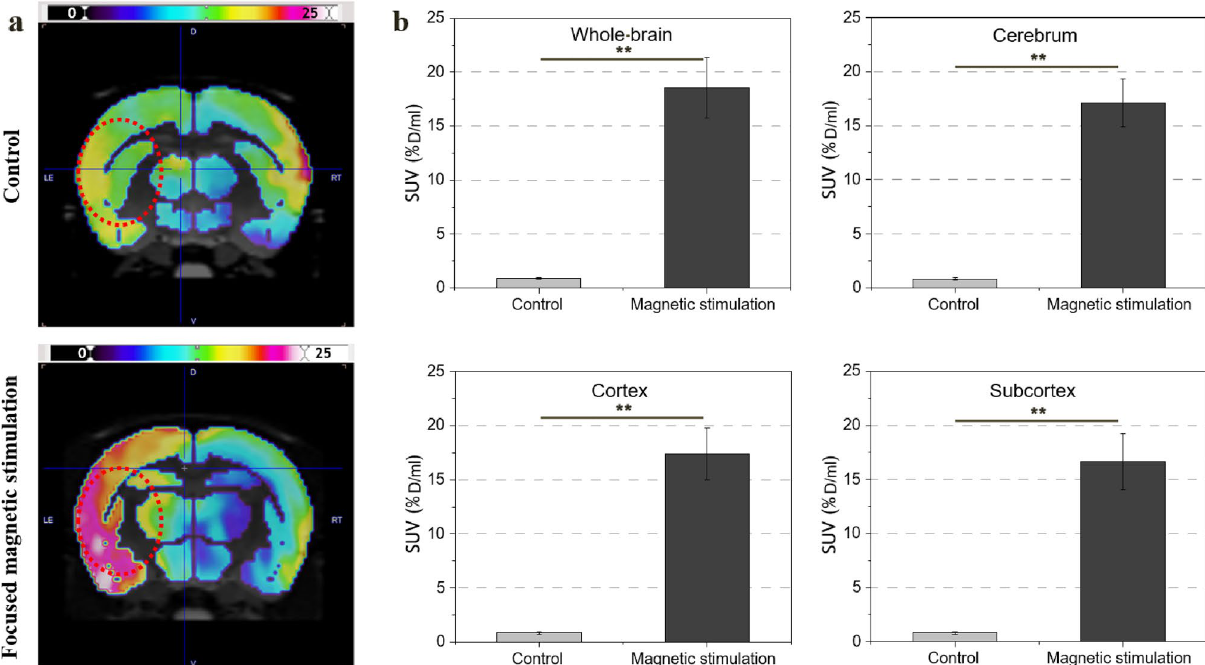
Figure 8. Changes in SUV index in the control (n = 6) and focused magnetic stimulation groups (n = 9). ( a ) PET/CT images of brain activation after heating in the control and focused magnetic stimulation groups. ( b ) Comparison of SUV index in the cerebrum, cortex, and subcortex, and whole-brain average with and without magnetic stimulation. In the group to which the focused magnetic field was applied to the stroke lesion, a significant increase in metabolic activity was observed (p <